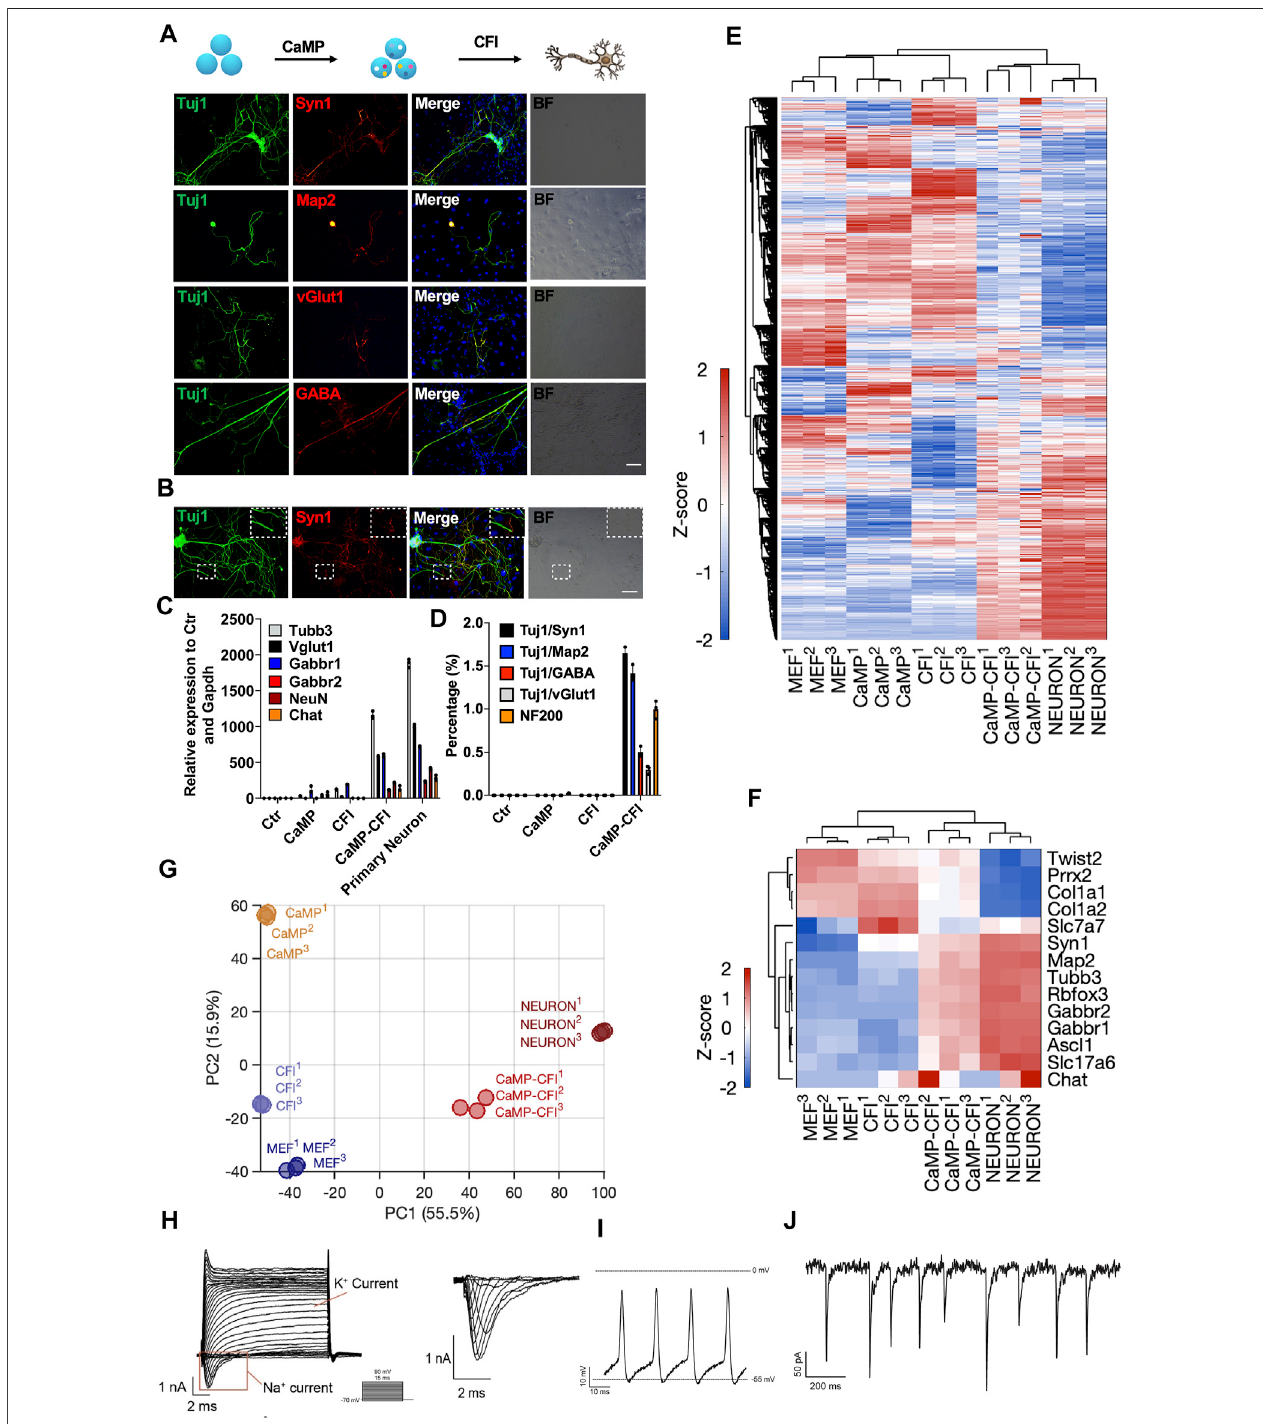
FIGURE 5 | Direct chemical reprogramming system into neuronal lineage was empowered with CaMP induction. (A) Immunostaining for the chemically induced neuron-like cells with the CaMP pretreatment. Scale bar, 100 μ m; CFI, CHIR99021/616452/Forskolin/ISX-9. (B) Immunostaining of CaMP-CFI induced functional synapses identi fi ed by Syn1 immunostaining. Scale bar, 100 μ m. (C) Relative mRNA expression of typical neuronal marker genes induced with or without CaMP pretreatment. (D) The ef fi ciency statistics of matured neuron-like cells identi fi ed by immunostaining. (E) Gene expression heatmap of all differentially expressed genes (normalized FPKM changed more than 1.5 among the samples) in neuron-like cells induced with or without CaMP step. The color key, Z-score of normalized FPKM. (F) Gene expression heatmap of typical neuron genes in neuron-like cells induced with or without CaMP step. The color key, Z-score of normalized FPKM. (G)